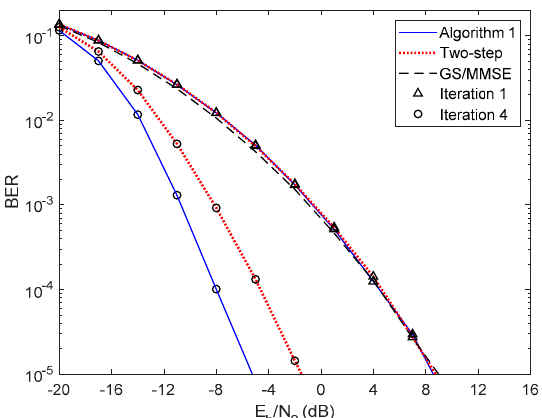
Figure 5. Performance comparison between the Algorithm 1, the two-step, and GS/MMSE approaches for the NCSI precoder with ULA configuration and QPSK modulation.